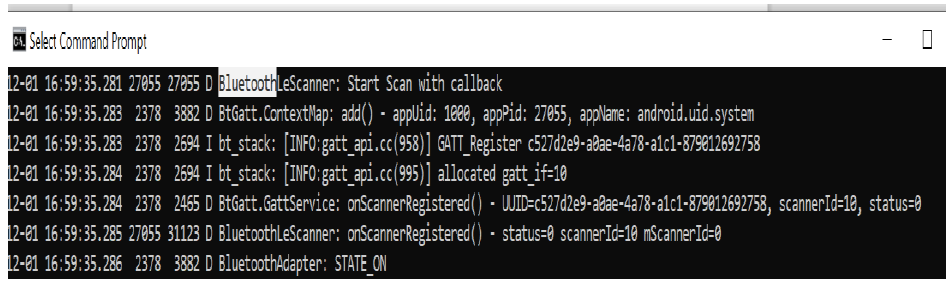
Figure 18. BlueSPP app execution time of action for Alpha 1P robot.